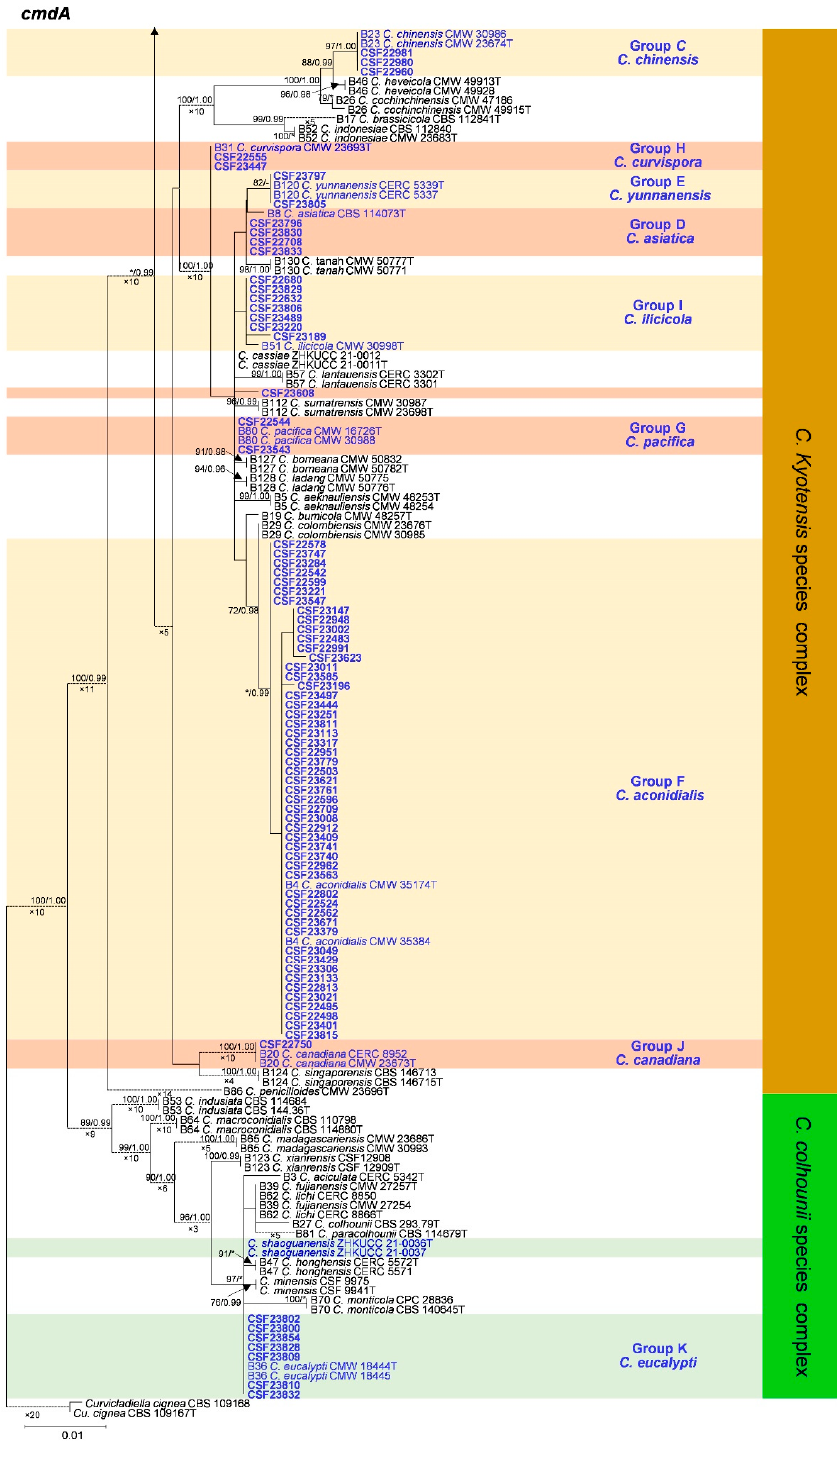
Figure A3. Phylogenetic tree of Calonectria species based on maximum likelihood (ML) analysis of the DNA dataset of the cmdA gene sequences. Bootstrap support values ≥ 70% from ML analysis and posterior probabilities values ≥ 0.95 obtained from Bayesian inference (BI) are indicated at the nodes as ML/BI. Bootstrap values < 70% or posterior probabilities values < 0.95 are marked with “*”, and absent analysis values are marked with “-”. “*/*”, “*/-”, “-/*”, and “-/-” are not displayed. Isolates obtained in this study are highlighted in blue and bold. Ex-type isolates are indicated with “T”. The “B” species codes are consistent with the recently published results of Liu and co-authors